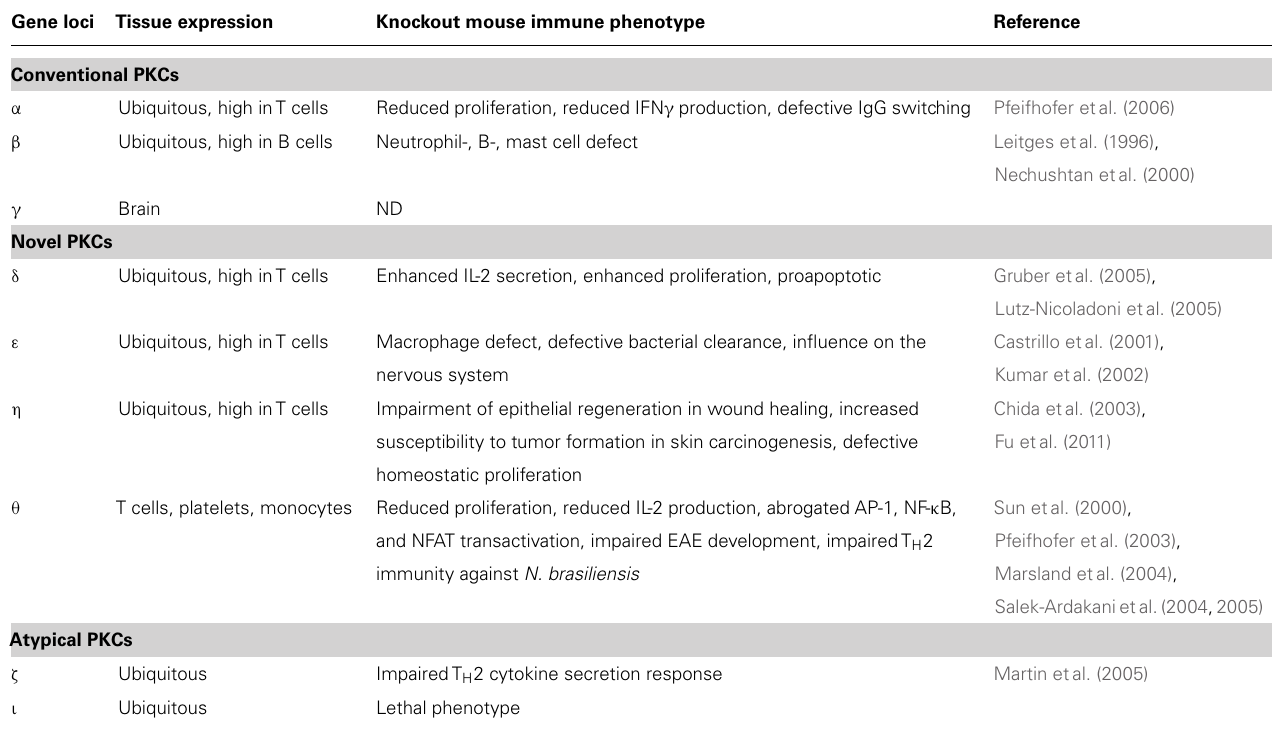
Table 1 | Lymphoid expression pattern and immune cell phenotypes of PKC isotype knockout mice. Gene loci Tissue